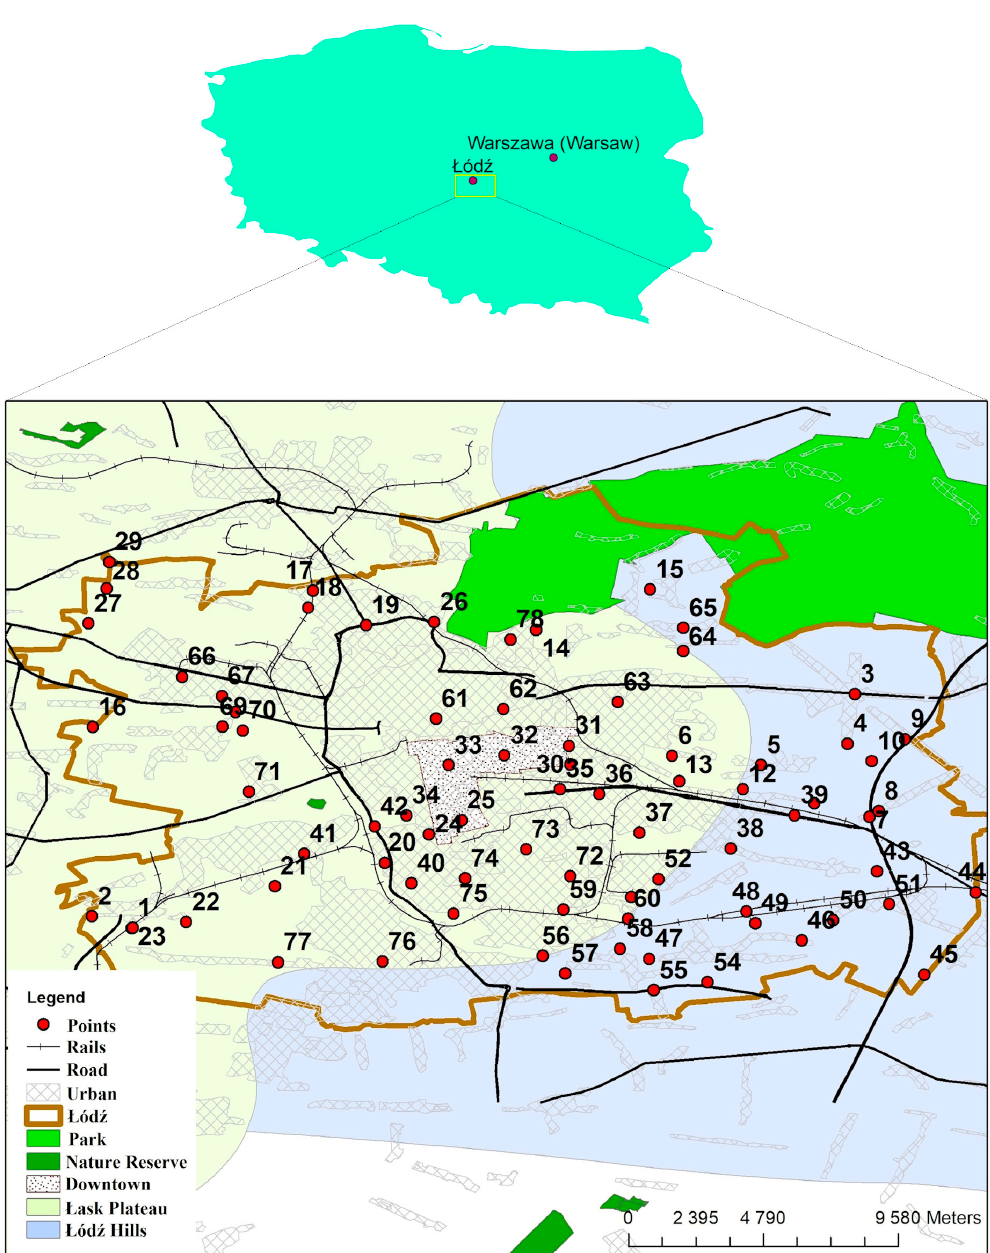
Figure 1. Location of the sampling sites in Ł ód ź (Poland).